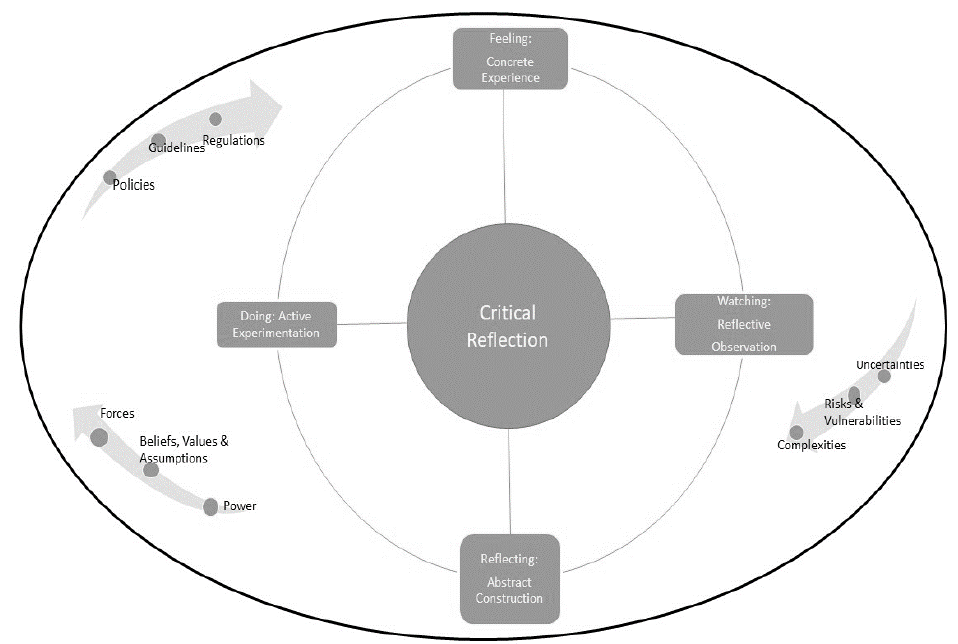
Figure 1. The framework of environment within which the practice of SWS takes place.